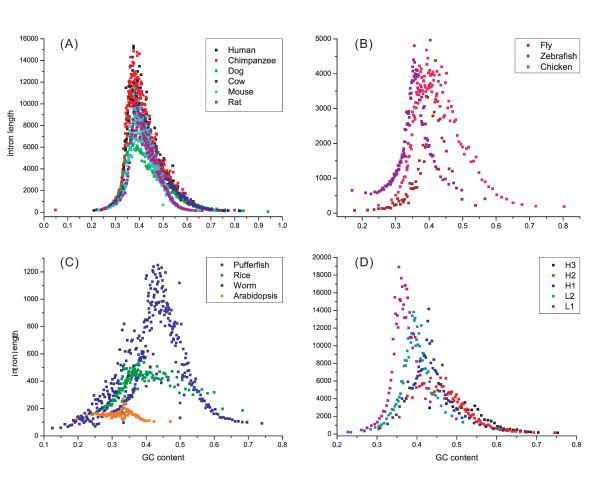
Variation patterns of introns' length, as a function of GC content. Each dot contains 1000 introns (A-D). The species in A-C were grouped based on ranges of intron lengths, e.g., up to 16000 bp for mammals. L1, L2, H1, H2 and H3 in D represent five GC-isochore families in human genome [22] which are different in GC content (0~0.37, 0.37~0.41, 0.41~0.46, 0.46~0.53, 0.53~1, respectively). Genes that cover two or more family regions were excluded in D. The x-axis scale in A – D is based on the actual GC content in different genomes.